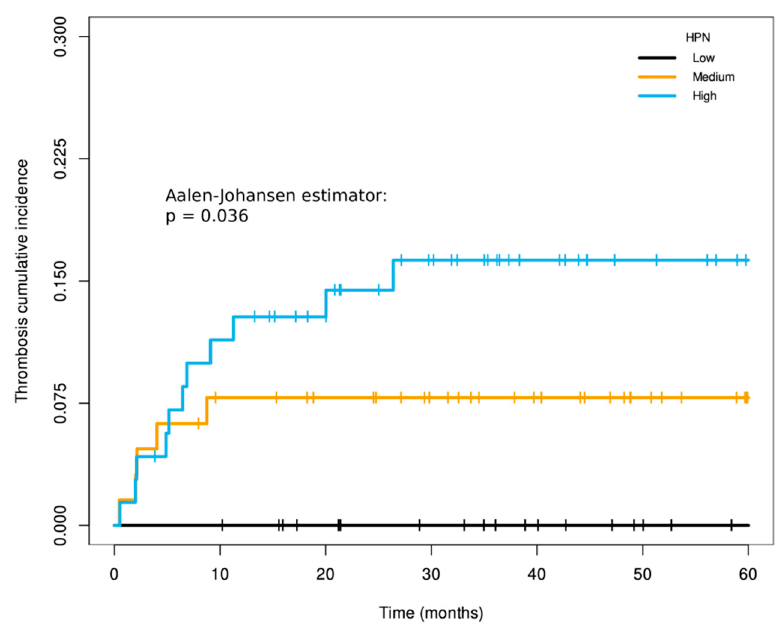
Figure 4. Cumulative incidence of thrombosis independent of relapse among localized patients according to Hepsin staining. Time on the X-axis corresponds with the months of follow-up since tumor diagnosis. The p -value from the Aalen–Johansen estimator gives information on the degree of significance of the differences between the three groups of patients. p : p -value of the Aalen– Johansen estimator; HPN: Hepsin.